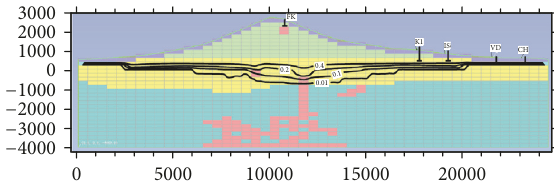
Figure 8: Distributions of modeled gas saturation values (Sg) (TOUGH2-EOS1) (6A). Horizontal and vertical axes are labeled in